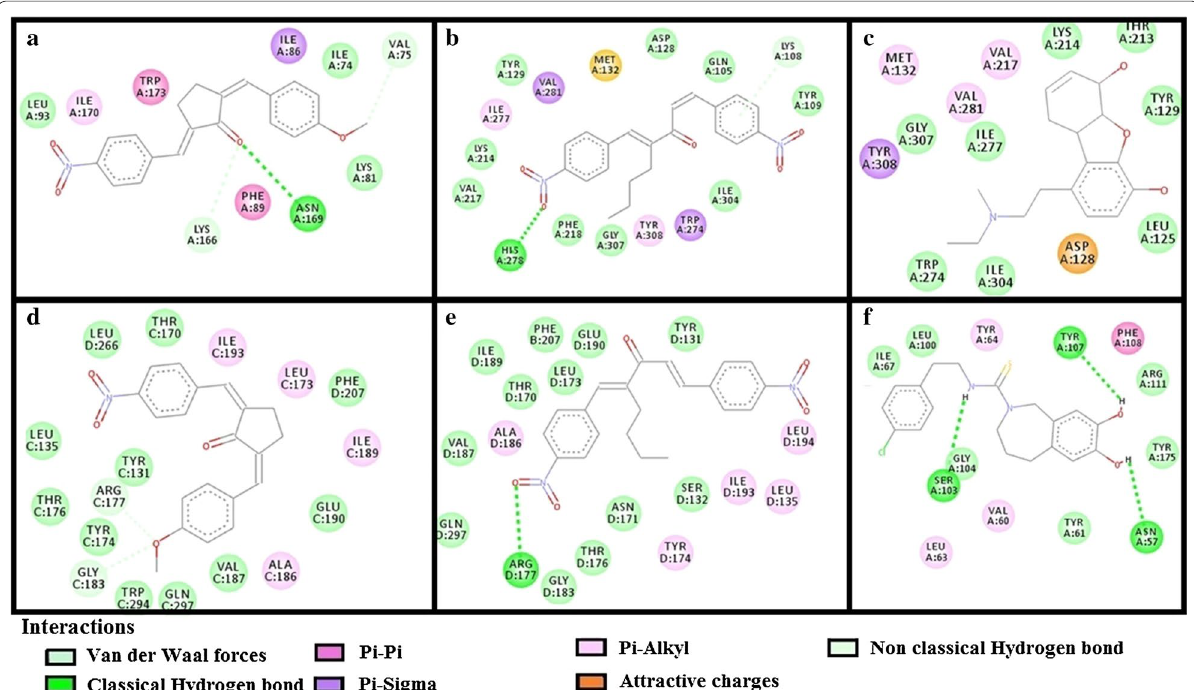
Fig. 6 a – c Represents interactions of ligands: (2 E ,5 E )‑2‑(4‑methoxybenzylidene)‑5‑(4‑nitrobenzylidene) cyclopentanone (AK‑1a), (1 E ,4 E )‑4‑(4‑nitro benzylidene)‑1‑(4‑nitrophenyl) oct‑1‑en‑3‑one (AK‑2a) and morphine with target: delta receptor respectively. d – f Represents interactions of AK‑1a, AK‑2a and capsazepine with target: human capsaicin receptor (HCR) respectively, drawn through Biovia Discovery Studio Visualizer client 2016